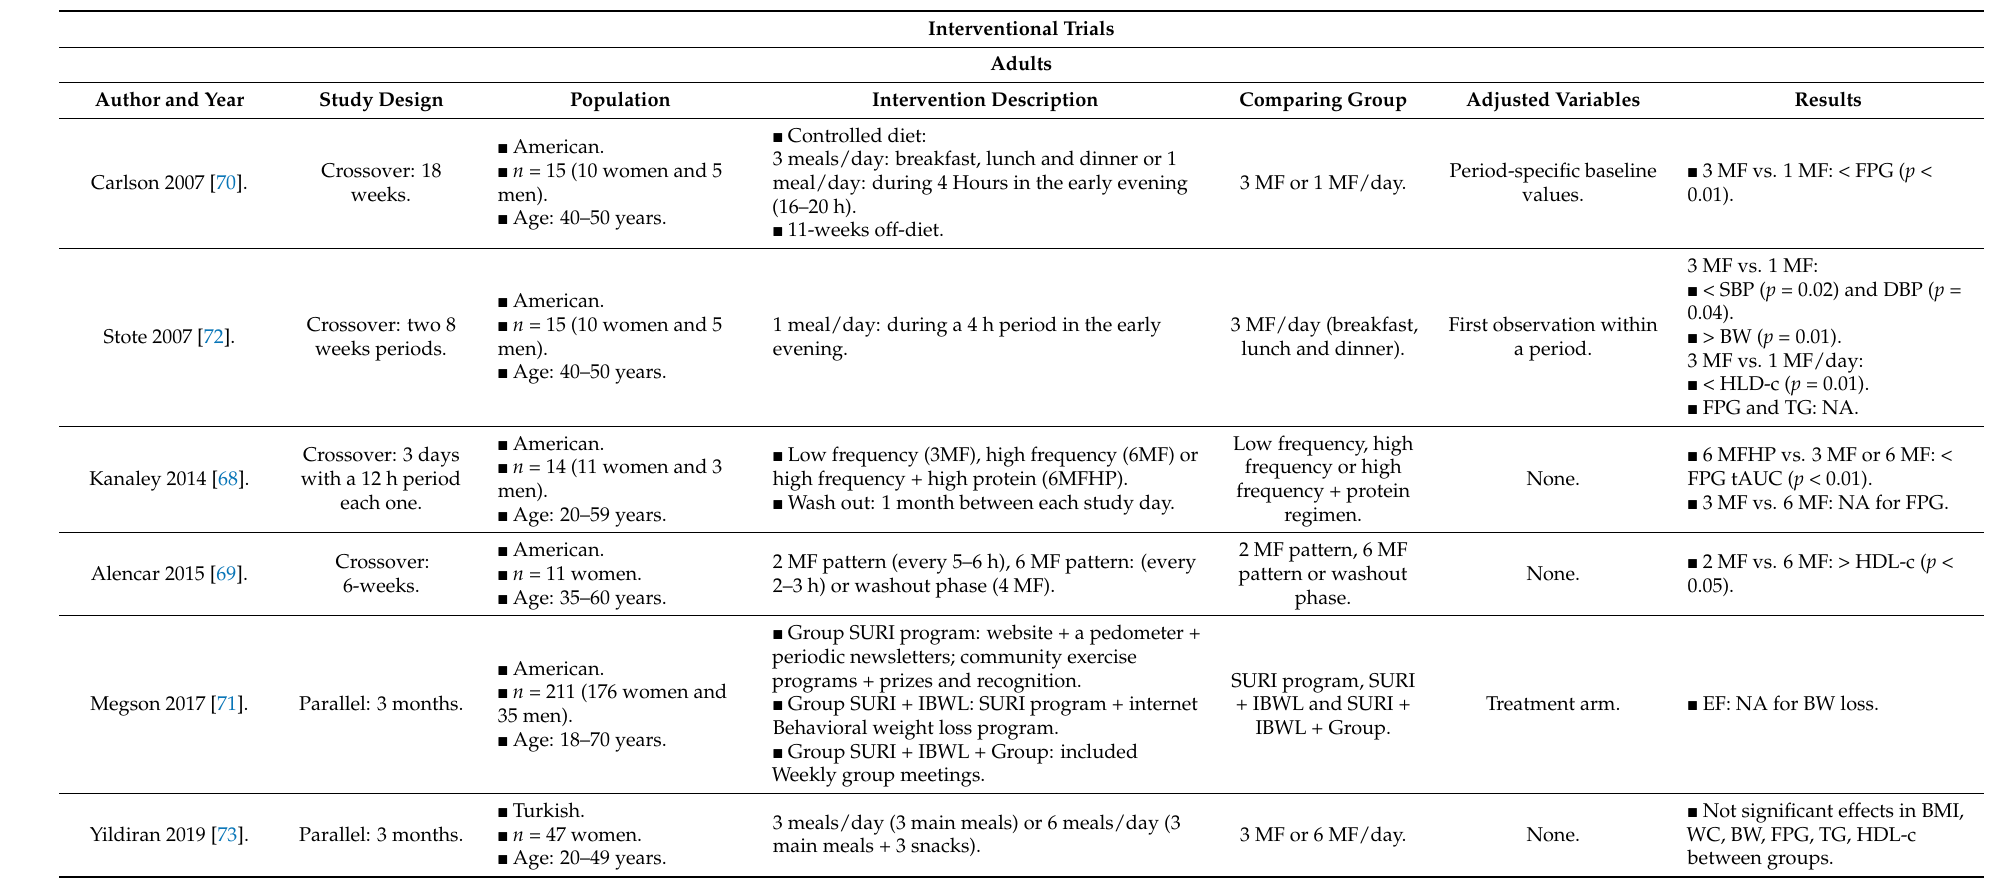
Table 6. Characteristics and main findings of interventional trials that explored eating frequency. Interventional Trials Adults Study Design Population Intervention Description Comparing Group Adjusted Variables